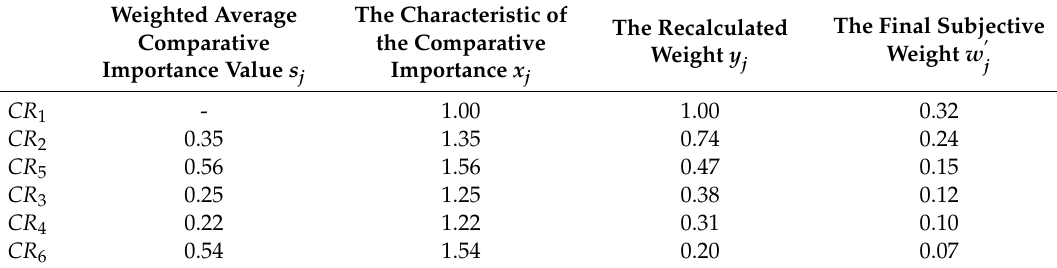
Table 8. The final subjective weights of CRs.